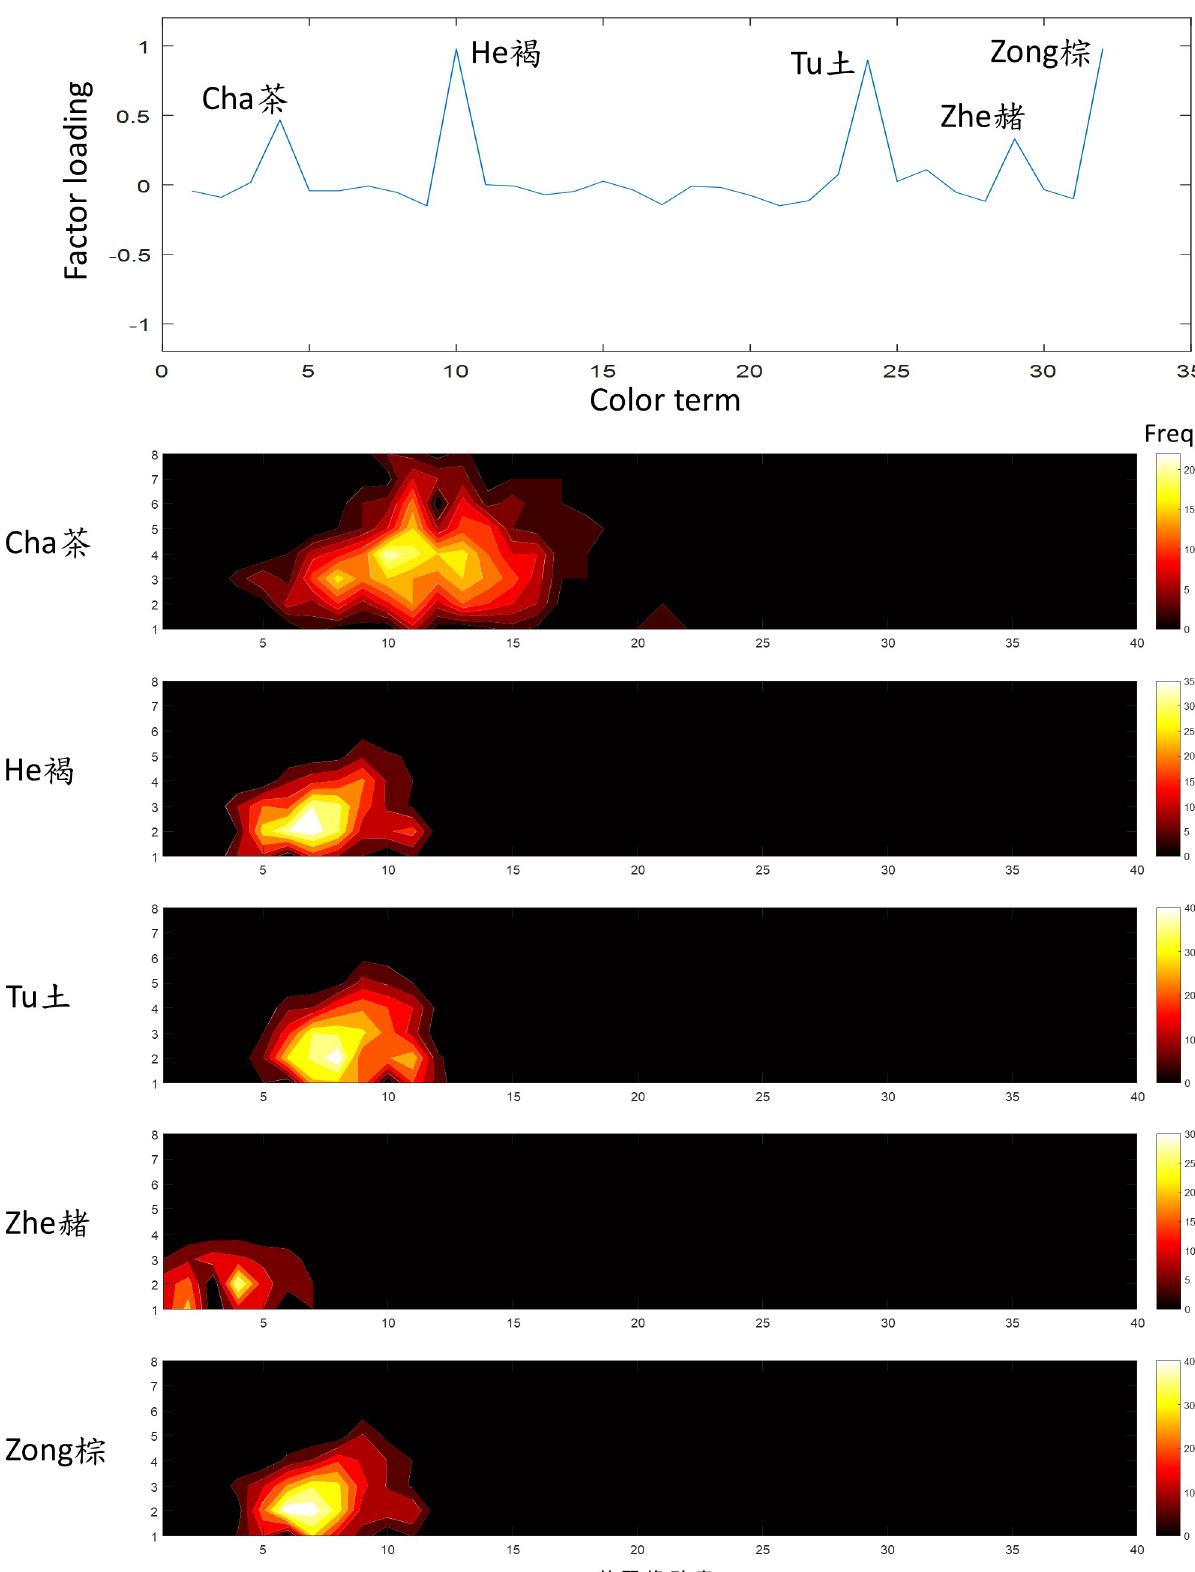
Fig 7. The third factor was “green”. The terms Cai , Cui , Lu , Bi and Qing ( 菜 , 翠 , 綠 , 碧 , 青 )showed a high loading on this factor. The convention of the figure is the same as Fig 5. https://doi.org/10.1371/journal.pone.0206699.g007 PLOS ONE | https://doi.org/10.1371/journal.pone.0206699 November28,